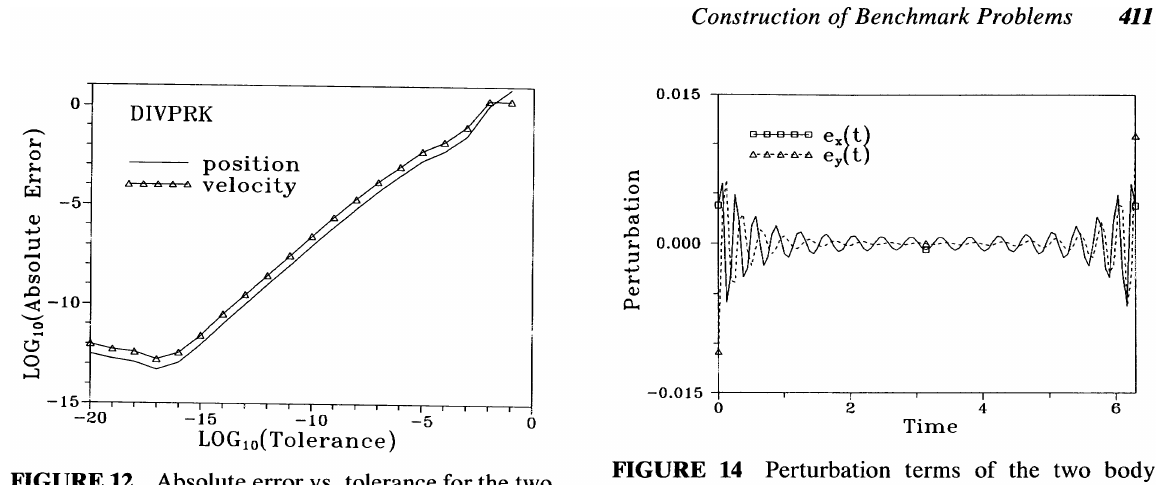
FIGURE 12 Absolute error VS. tolerance for the two body problem (DIVPRK).